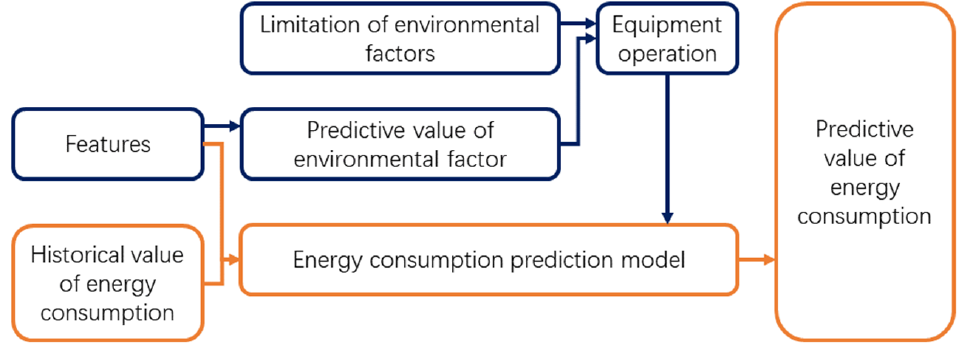
Figure 2. Two methods of CEA building energy consumption prediction.